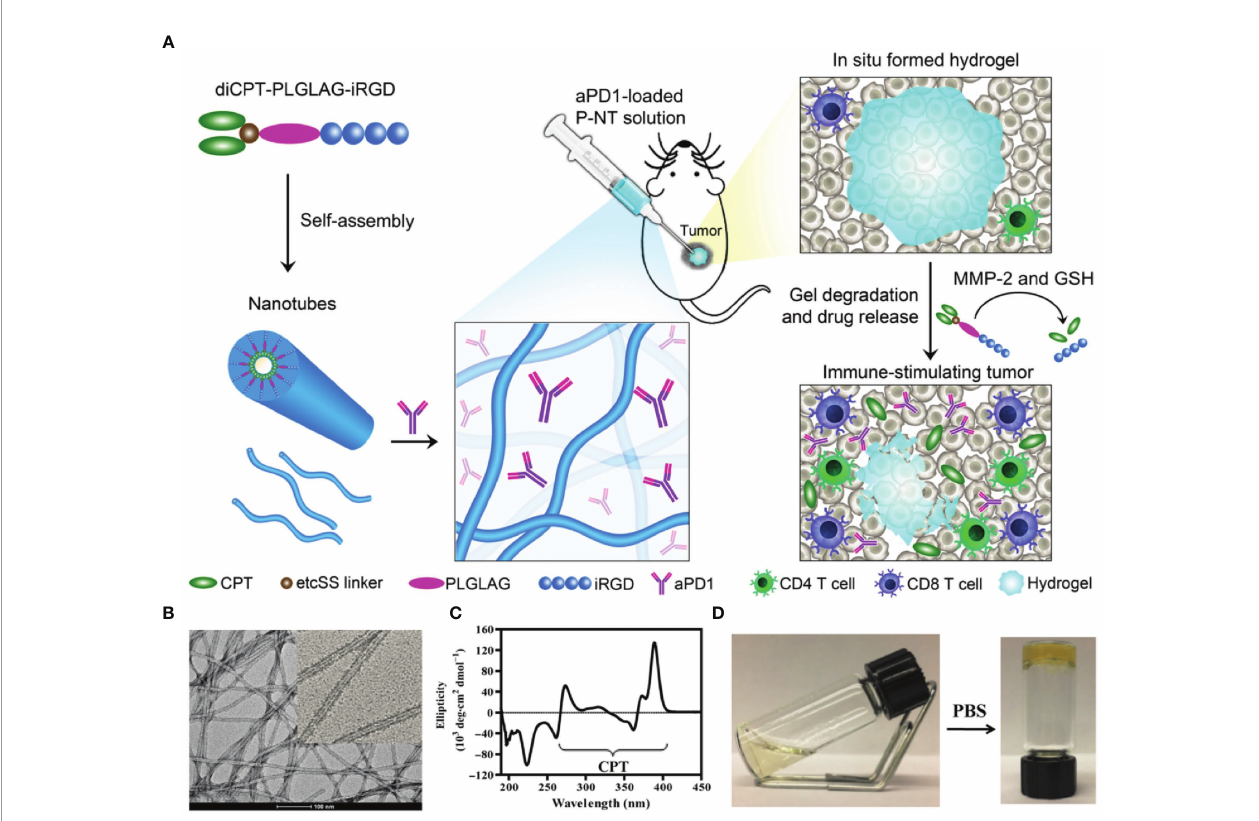
FIGURE 2 | Schematic illustration of the in situ formed P-NT-anti-PD-1 hydrogel. (A) In situ formation of P-NT-anti-PD-1 hydrogel, which enables localized CPT and anti-PD-1 delivery and promotes the activation of CD4 and CD8 T cells in the tumor microenvironment. (B) Representative transmission electron microscopy (TEM) image of the networks of the P-NT hydrogel. (C) Circular dichroism (CD) spectrum of camptothecin (CPT) solution. (D) Photographs of liquid P-NT transformed into hydrogel after the addition of phosphate-buffered saline (PBS). Reprinted with permission from Science Advances